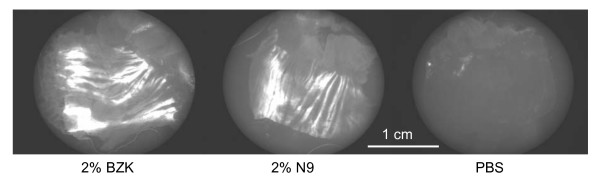
Surface distribution of acute toxicity to vaginal epithelium caused by a 10-minute exposure to detergents. Fluorescent intensity of the 'dead cell' dye YOYO-1 is proportional to the density of cell nuclei in the epithelium whose membranes were disrupted by the detergents. The brightly stained swaths of epithelium are regions in which virtually every cell nuclei became stained with YOYO-1. The darker regions became visible as the vagina was gently stretched and flattened to unfold the rugae.